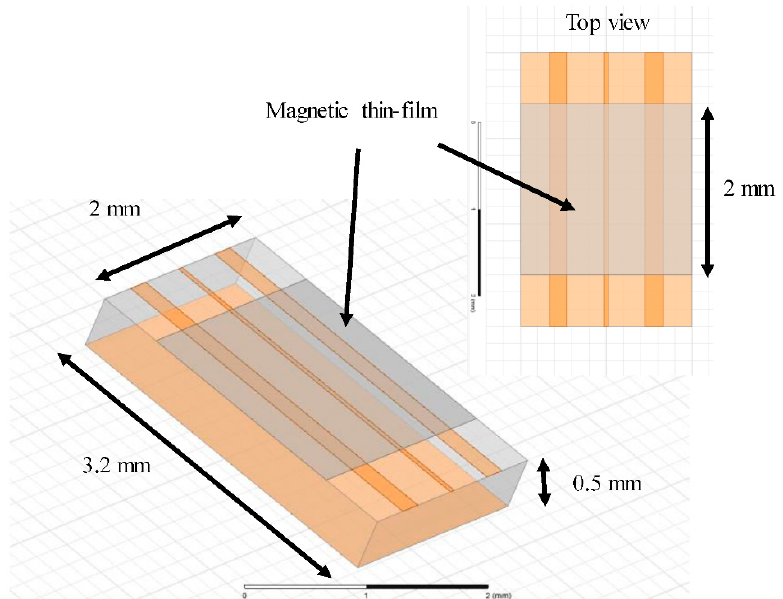
Figure 1. Schematic representation of the miniaturized CPW showing the location of the 107 nm thick